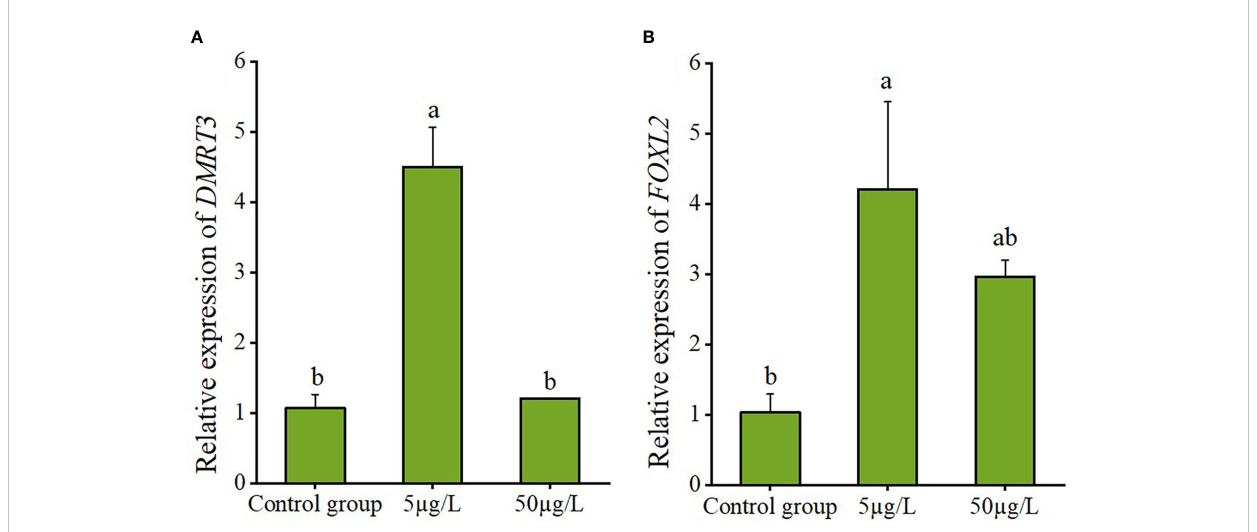
FIGURE 9 The relative expression levels of DMRT3 in the testis (A) and FOXL2 in the ovary (B) of C. sinensis under estradiol exposure treatments. Different letters represent signi fi cant differences ( P<0.05